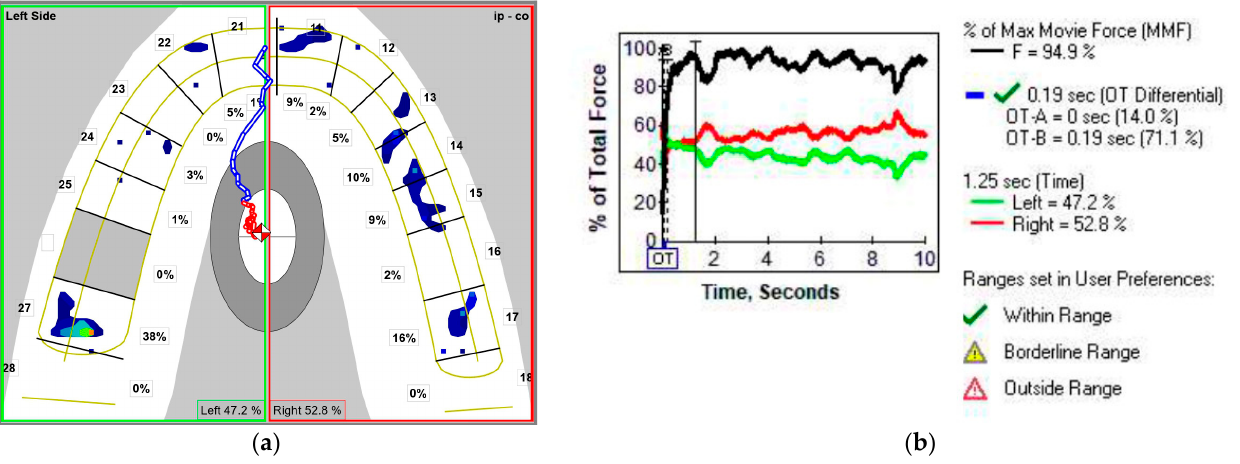
Figure 5. MA frame of the T-Scan registration of MC subject in TNP: ( a ) 2D view with the distribution of the occlusal force between the left and the right side of the arch; ( b ) graph of the % of the total force in time, with %MMF, OT, OTB, and MAT (1.25 s).